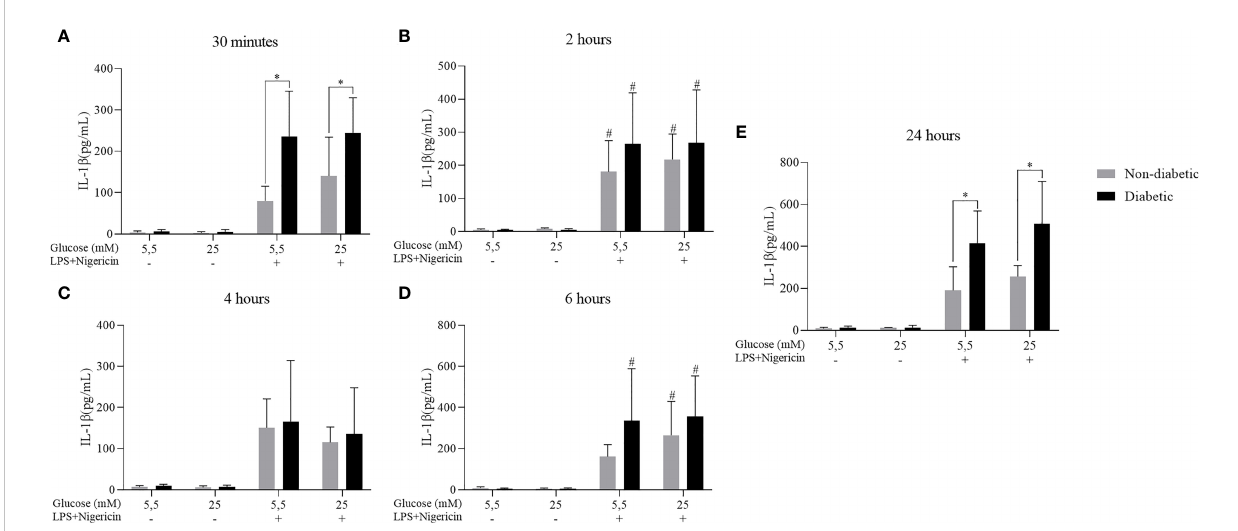
FIGURE 6 IL-1 b secretion by ND-BMDM and D-BMDM with Nigericin priming and LPS stimulation. IL-1 b release after (A) 30 minutes with different glucose concentrations. *P<0.05 D-BMDM 5.5Mm+ vs ND-BMDM 5.5mM+. *P<0.05 D-BMDM 25Mm+ vs ND-BMDM 25mM+. (B) 2 hours with different glucose concentrations. #P<0.05 stimulated groups vs non stimulated. (C) 4 hours with different glucose concentrations. (D) 6 hours with different glucose concentrations. #P<0.05 stimulated groups vs non stimulated. (E) 24 hours with different glucose concentrations. *P<0.05 D-BMDM 5.5Mm+